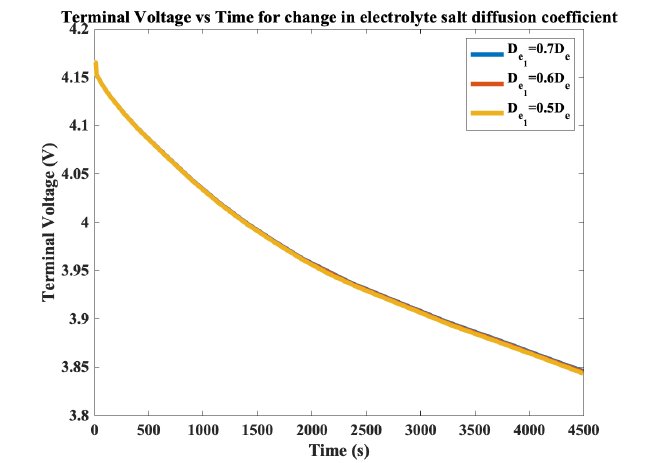
Figure 4. Terminal voltage vs. time for change in electrolyte salt diffusion coefficient from 0.7 to 0.5.